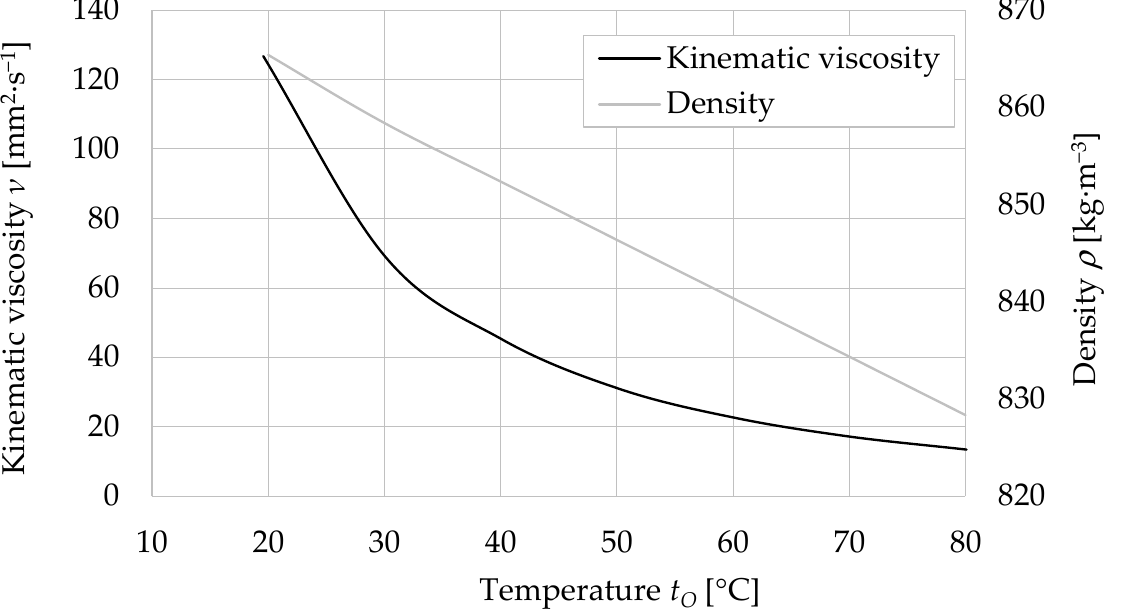
Figure 5. Dependence of oil kinematic viscosity and density on oil temperature.